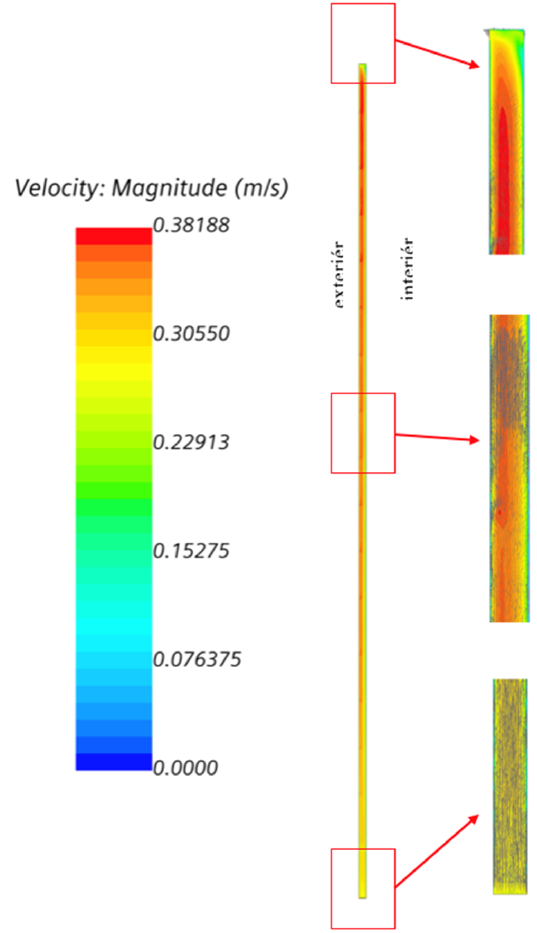
Figure 17. Visualization of velocity field in air gap in façade vertical cross section winter extreme.